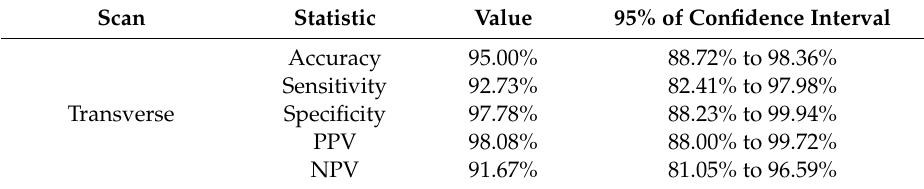
Table 6. Performance based on hybrid feature vector using transvers scan of OASBUD dataset. Ensemble (Preset: Ensemble method: RUSBoost, RUSBoosted trees, learner type: Decision tree, number of learners: 30, maximum number of splits: 20, learning rate: